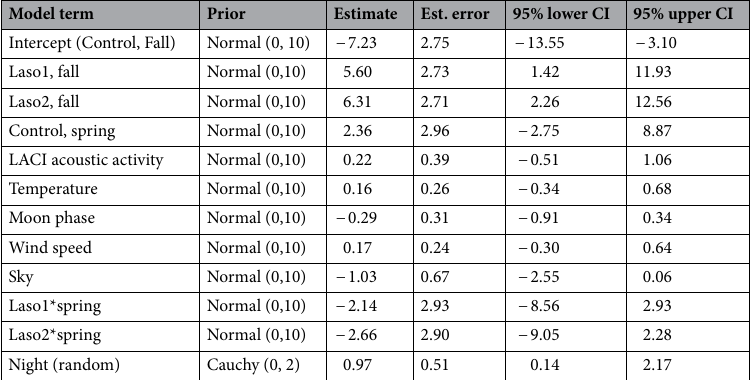
Table 2. Parameter estimates, prior designations, estimated error, and 95% credible intervals for multilevel model examining response of hoary bats ( Lasiurus cinereus ) to social call